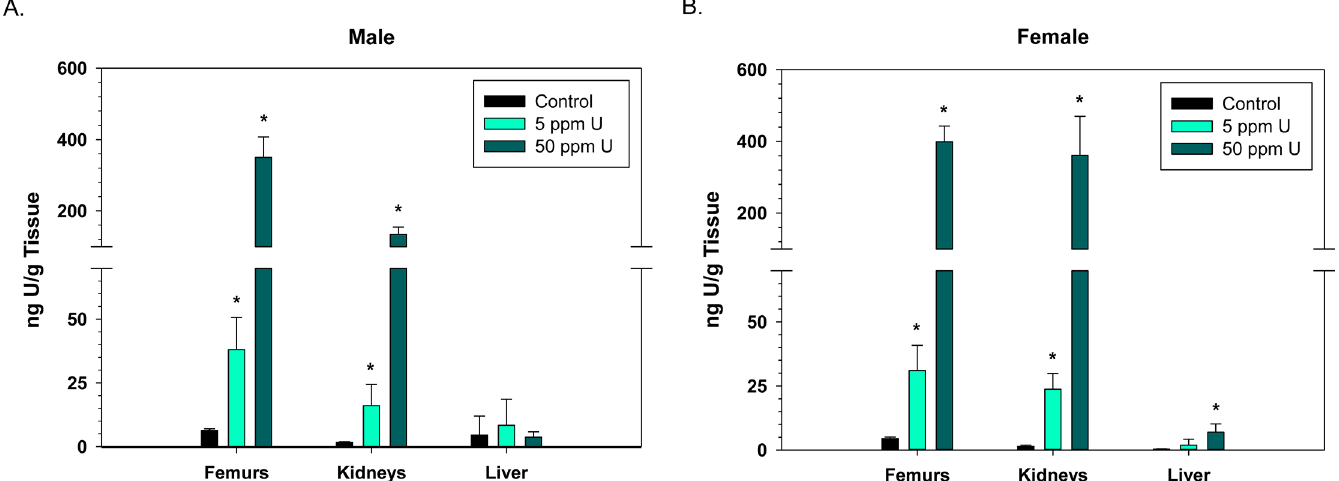
Fig 2. Uranium accumulates in the bone and kidney following a 60-d oral exposure. Uranium concentrations in harvested mouse tissues (femur bones, kidneys, and liver) were analyzed by ICP/MS, following an oral 60-d exposure to uranyl acetate. Graph indicates mean ng uranium/g of tissue +/- S.D. of mean for each tissue in male (A) and female (B) mice. n = 6 or 7/ group. (cid:3) p < 0 . 05 ;One-Way ANOVA or Kruskal Wallis ANOVA, as appropriate.